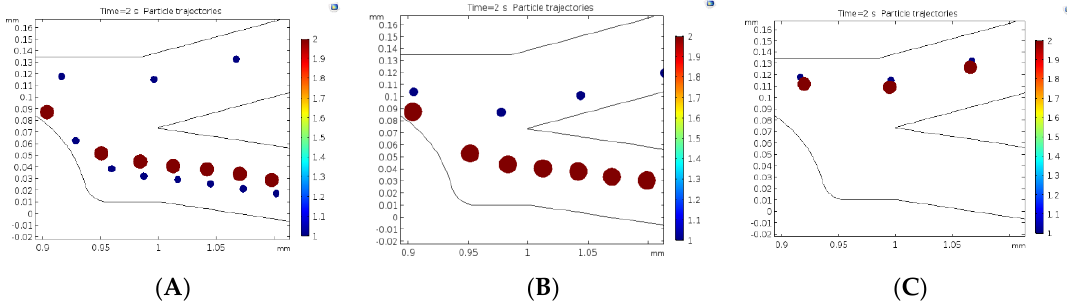
Figure 8. Particle trajectories showing partial ( A , C ) and complete separation ( B ) at various voltage conditions. The constriction diameter was fixed at 100 µm along with number of constrictions at 5. ( A ) shows incomplete separation at <50 V DC , ( B ) complete separation at 50 V DC , ( C ) no separation at >100 V DC .